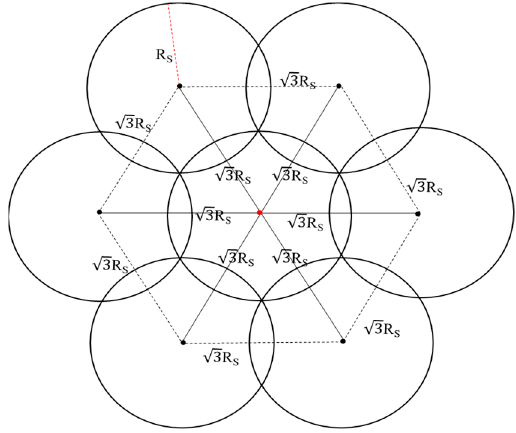
Figure 3. Diagram of the adaptive expansion based on the minimum overlapping full-coverage model (AE-MOFCM). The red point is a single given location; the red dashed line means the sensing radius of sensors, and the value is Rs; while the black points are subsequent points that can be obtained by the corresponding formula.